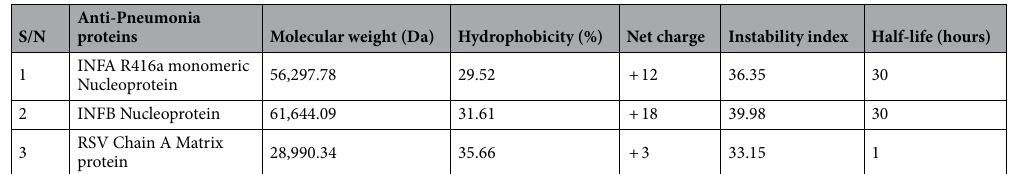
Table 6. Physicochemical properties of the retrieved pneumonia receptor proteins. INFA Influenza A virus, INFB- Influenza B virus, RSV Respiratory Syncytial virus.